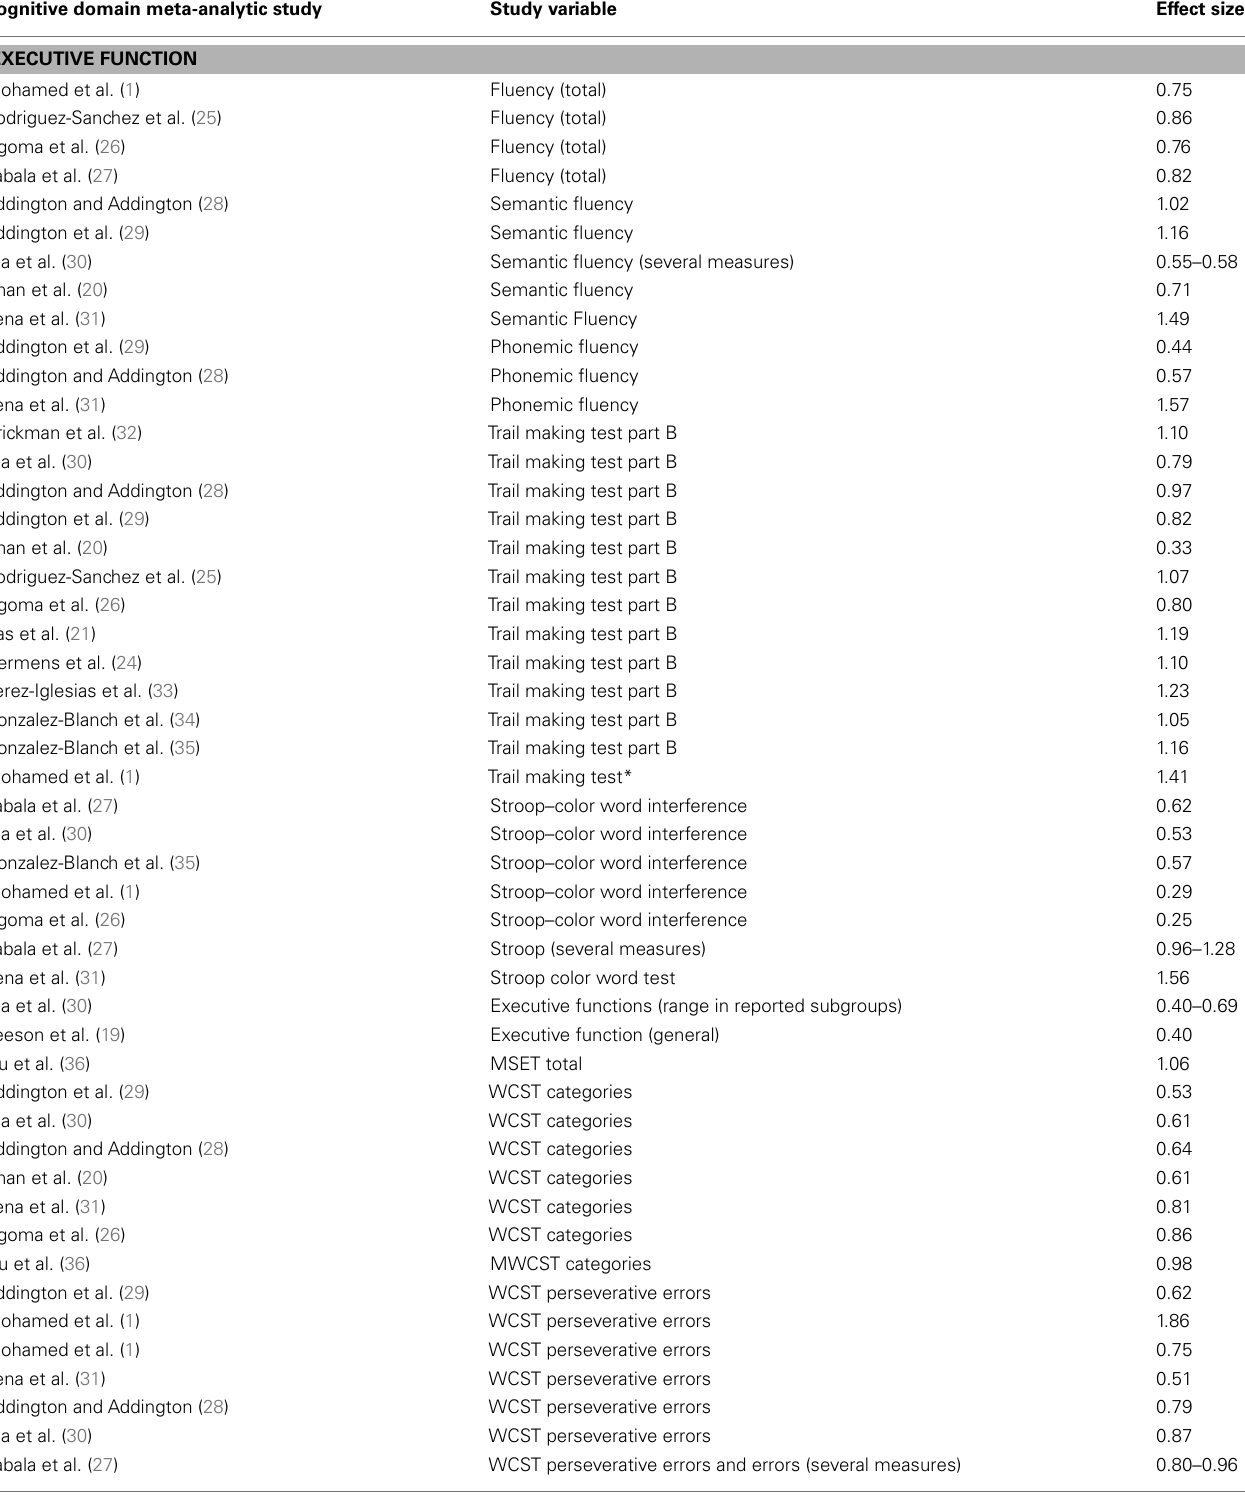
Table 2 | Studies comparing patients with first-episode psychosis and healthy controls on executive function, attention and working memory